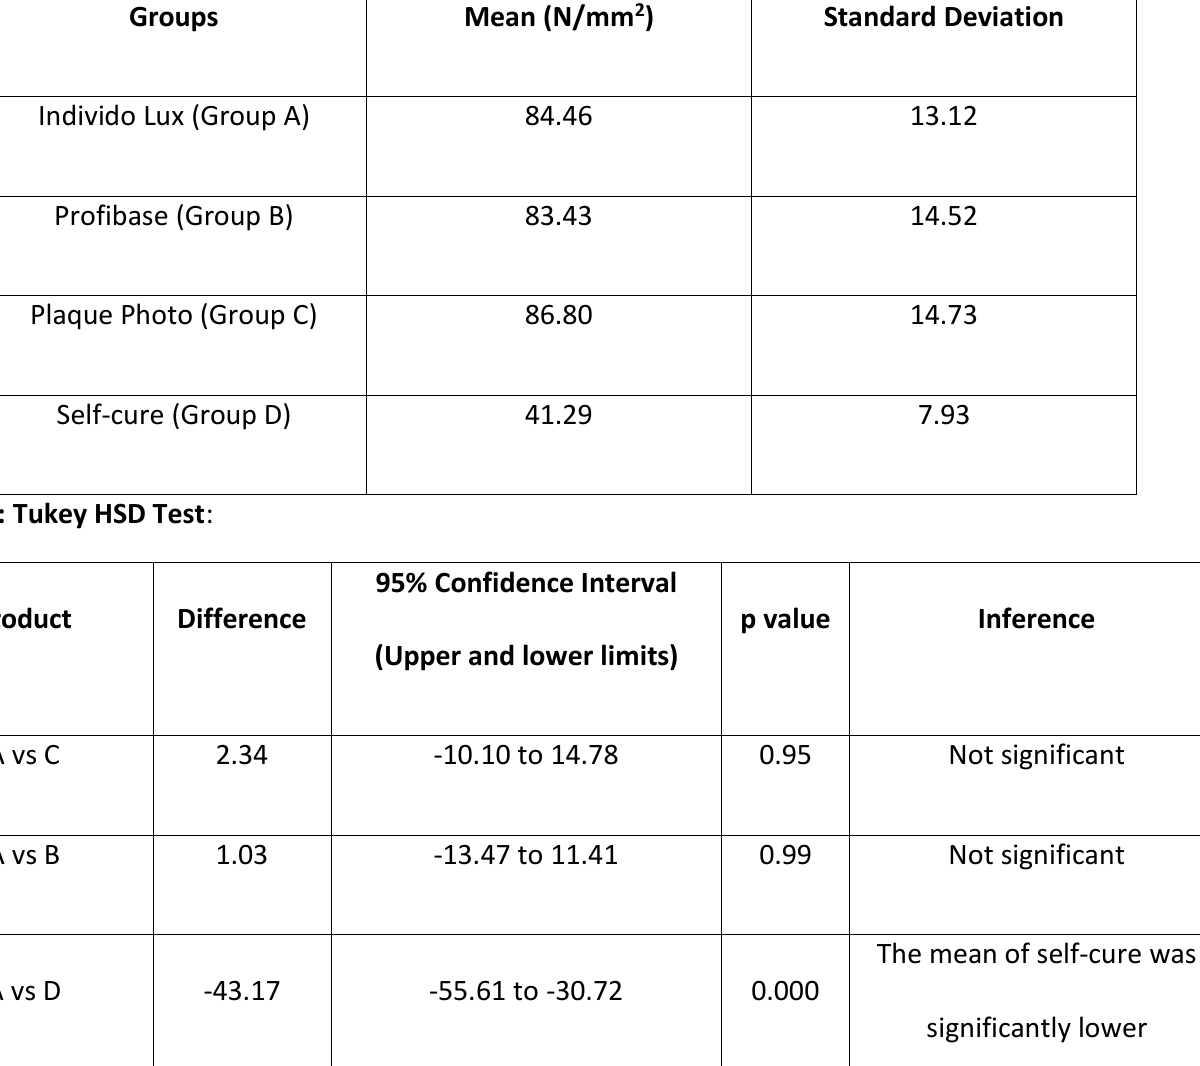
Table 1.1: Inter group comparison of the four test groups with respect to the flexural strength in N/mm 2 :